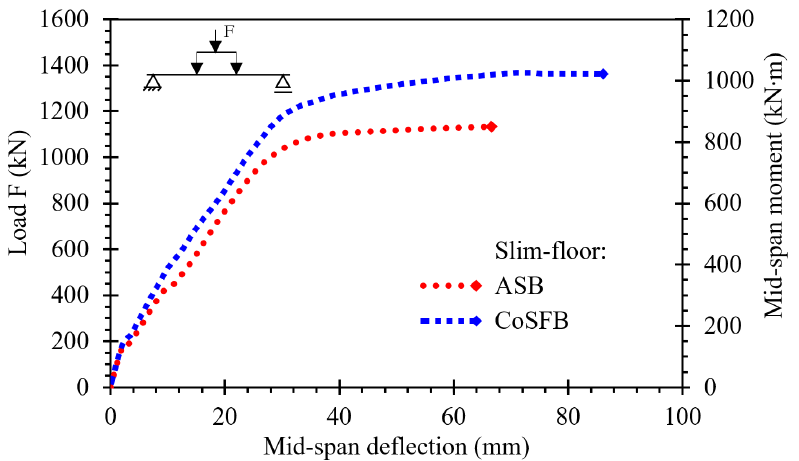
Figure 17. Comparative graph of flexural behavior.